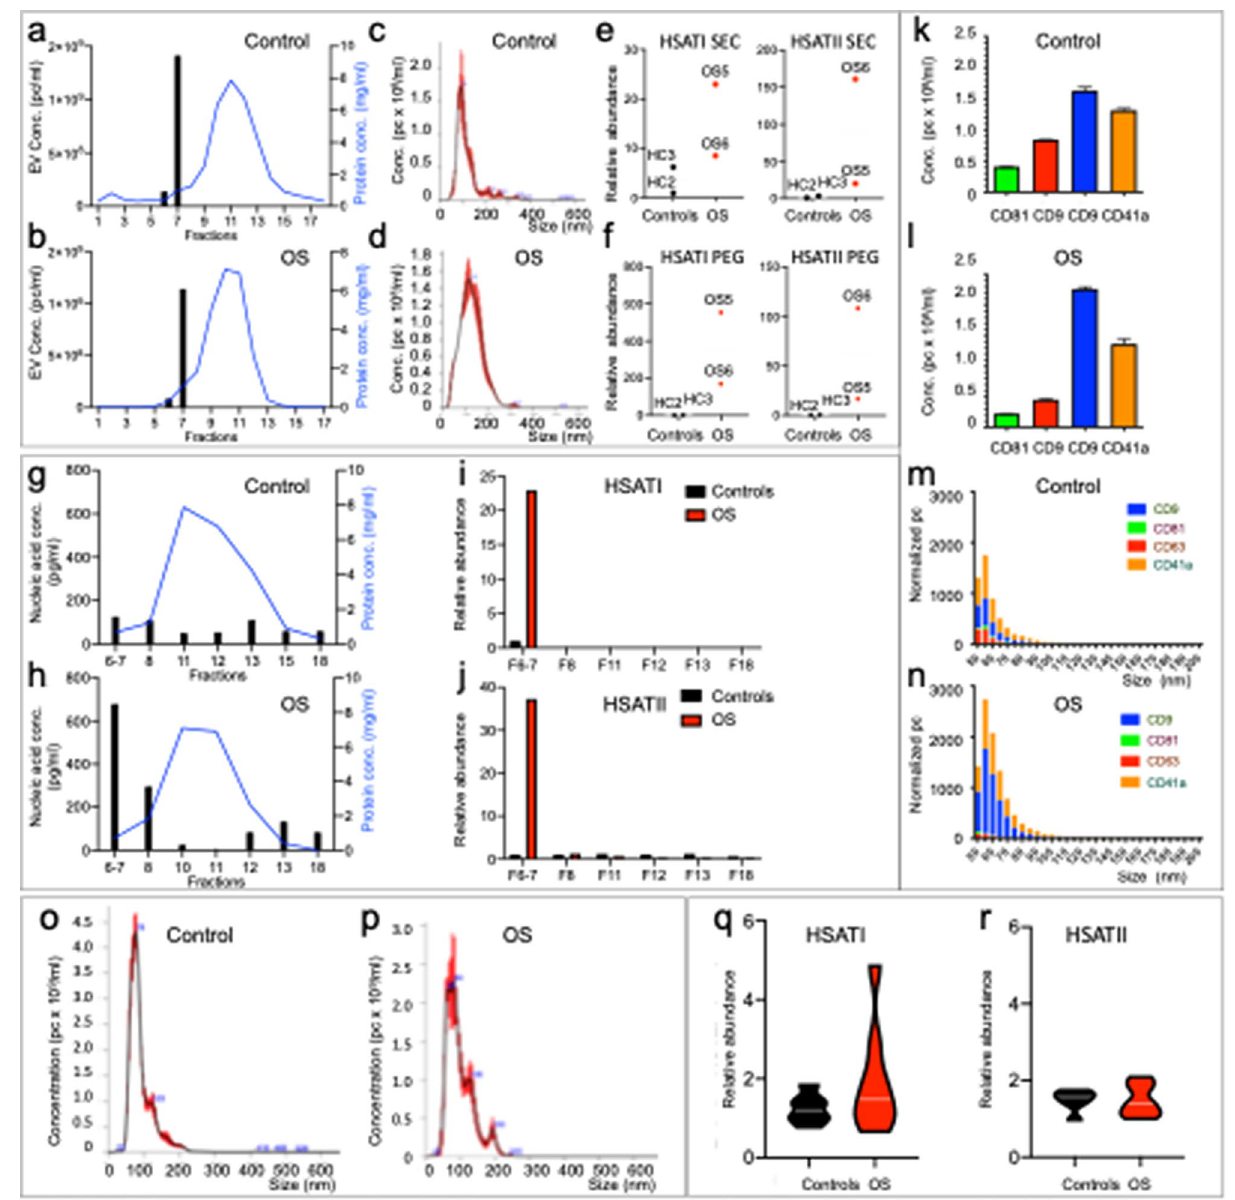
Figure 5. Co-purification of OS-associated repetitive element DNAs with EVs in size exclusion chromatography but not exosome immunoaffinity capture. ( a , b ) Representative protein concentration (blue line) and EV concentration (black bars) elution profiles from control ( a ) and OS ( b ) serum separated by size exclusion chromatography (SEC). ( c , d ) Representative size distribution of control ( c ) and OS ( d ) serum EV particles in pooled fractions 6 and 7 analyzed by nanoparticle-tracking. ( e , f ) Relative abundance of HSATI and HSATII DNA in two control and two OS SEC ( e ) and PEG ( f ) EV fractions as defined by qPCR. ( g , h ) Representative protein concentration (blue line) and nucleic acid concentration (black bars) of pooled EV fraction (F6-7) and selected non-EV fractions (F8, F11, F12, F13 and F18) from the same representative control ( g ) and OS ( h ) SEC separations as in ( a ) and ( b ). ( i , j ) Abundance of HSATI ( i ) and HSATII ( j ) in pooled EV fractions 6–7 and non-EV fractions on one control and one OS SEC analysis as evaluated by qPCR. ( k – n ) SP-IRIS analyses by ExoView of EVs isolated by CD9-immunoaffinity capture. ( k , l ) Representative concentration of control ( k ) and OS ( l ) fluorescent EV particles immunocaptured on the CD9, CD81 and CD63 antibody spots. Results depict the mean of the measurement of triplicate spots ± SEM, subtracted for IgG spot values and adjusted by dilution factor. ( m , n ) Representative size distribution of control ( m ) and OS ( n ) label-free EV particles immunocaptured on the CD9, CD81 and CD63 antibody spots. Results depict the mean of the measurement of triplicate spots ± SEM, subtracted for IgG spot values. ( o , p ) Size distribution and particle number of control ( o ) and OS ( p ) EVs isolated by CD9 immunoaffinity capture and analyzed by nanoparticle-tracking. ( q , r ) Violin plots representing abundance of HSATI ( m ) and HSATII ( n ) of control (n = 6) and OS (n = 8) immunoaffinity capture of CD9-positive exosomes evaluated by qPCR. White lines represent median. Groups were compared using two ‐ tailed, unpaired, Mann Whitney U test; * p < 0.05. Similar CD81 immunoaffinity capture results in Supplementary Fig.